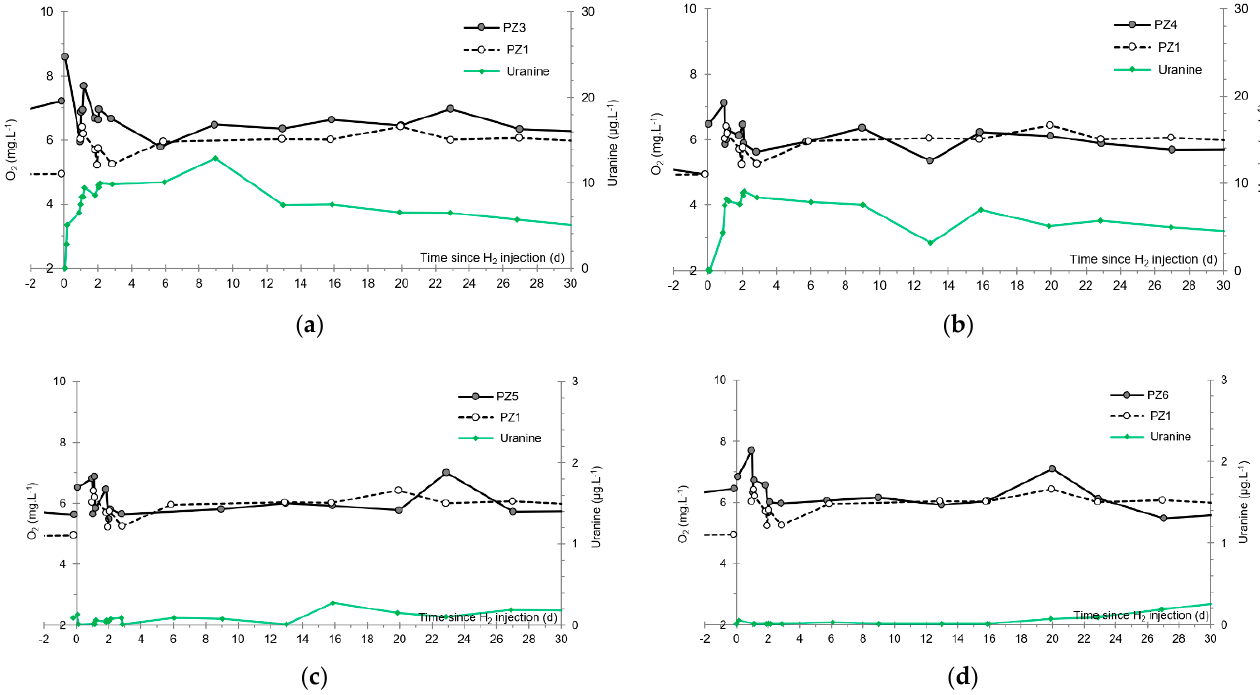
Figure 19. Comparative evolution of the dissolved oxygen during the dissolved hydrogen injection experiment at PZ1 (20 m upstream piezometer) and at the downstream piezometers: ( a ) PZ3 (10 m); ( b ) PZ4 (20 m); ( c ) PZ5 (30 m); and ( d ) PZ6 (60 m).